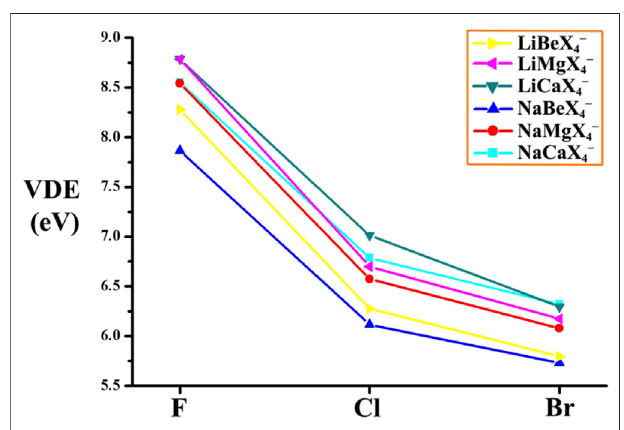
FIGURE 2 | The evolutions of VDE values ofthe MM ′ X 4 − and M ′ X 3 − (M = Li, Na; M ′ = Be, Mg, Ca, X = F ((from ref. [4]), Cl, Br) anions.